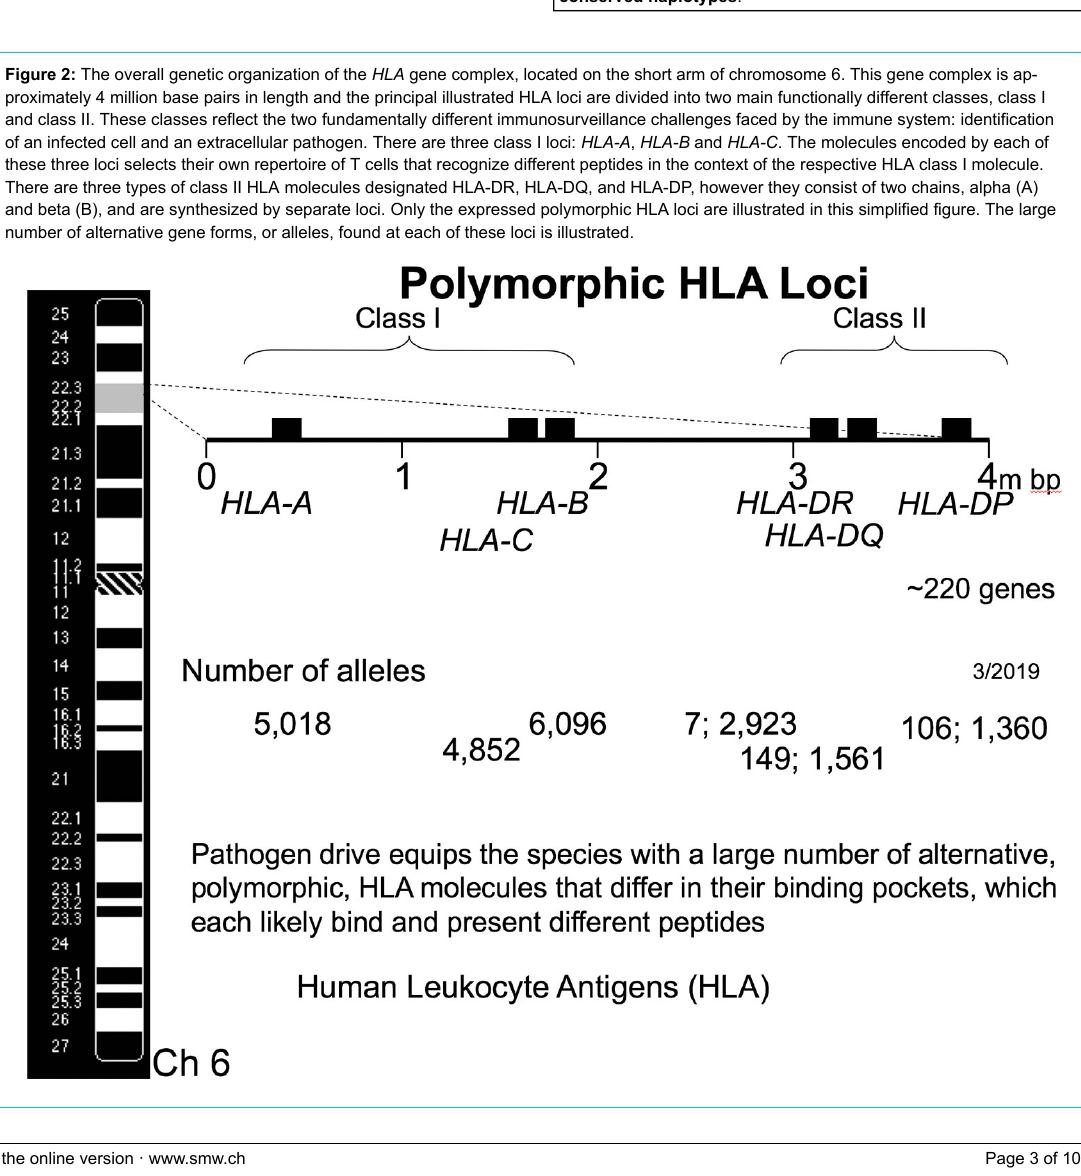
Table 1: Nomenclature used to describe the genetic polymorphisms of HLA genes. Alleles: the alternative forms of a gene found in different individuals (the gene name is usually italicized) Allotypes or allomorphs: the different or alternative protein forms encoded by alleles Genotype: the collection of genes in an individual, often referring to the two alleles of a single locus present on the respective maternal and pa- ternal chromosomes Haplotype: the genes (alleles) on a chromosome or region of the chromosome contributed by one parent. It is usually referred to by naming the principal alleles in the region. It can span across both class I and class II regions. Gene loci exhibit linkage , a measure of their genetic distance Linkage disequilibrium : certain alleles of different genes compris- ing a haplotype are found together significantly more (or less) fre- quently than expected by chance in certain populations and geo- graphic regions. These stable haplotypes are referred to as conserved haplotypes .